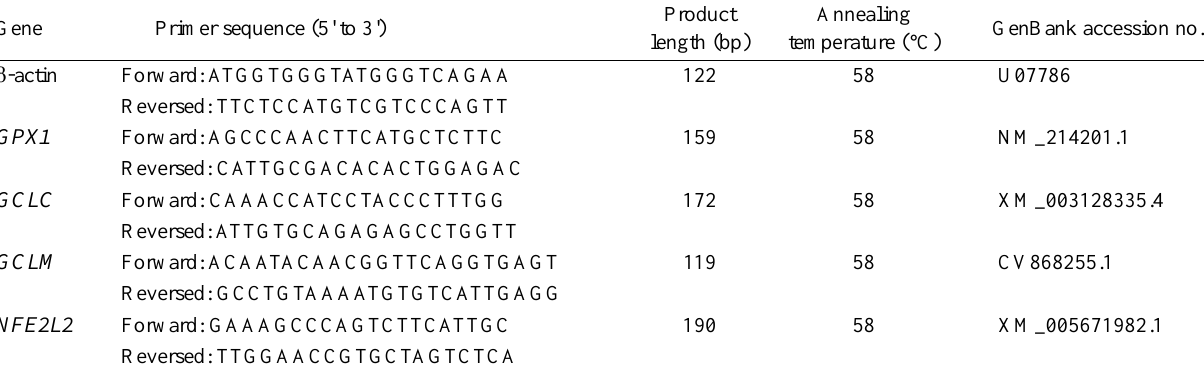
Table 2. Real-time quantitative PCR primers for NFE2L2-ARE related genes and β-actin of the finishing pigs